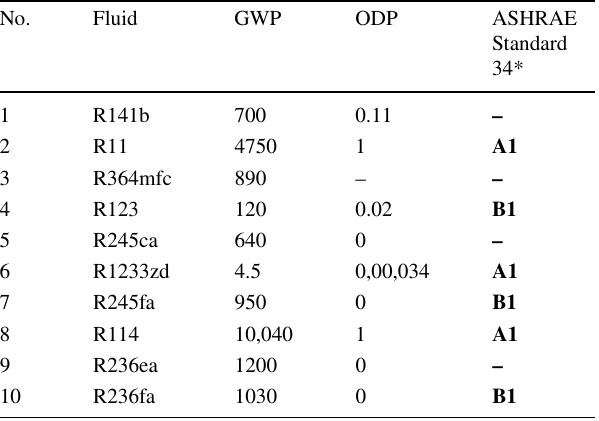
Table 6 Thermodynamic and environmental properties of organic working fluids (Tajik Mansouri et al. 2020)